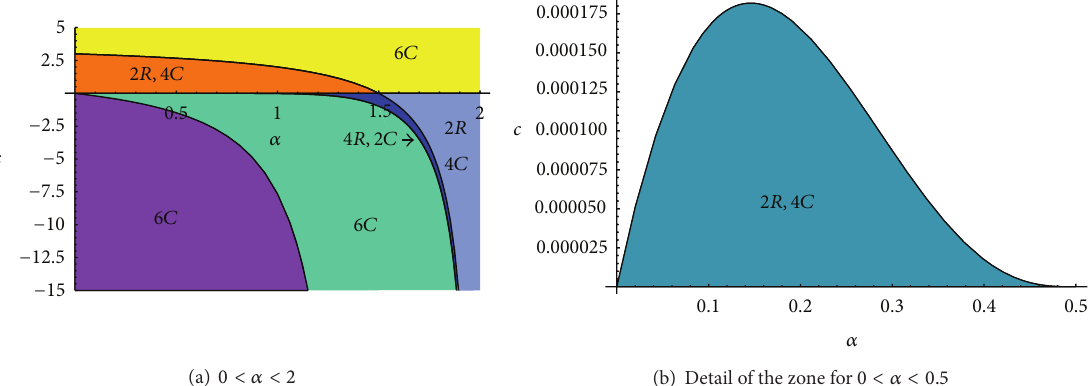
Figure 6: Critical points in the (𝛼, 𝑐) -plane for 0 < 𝛼 < 2 .